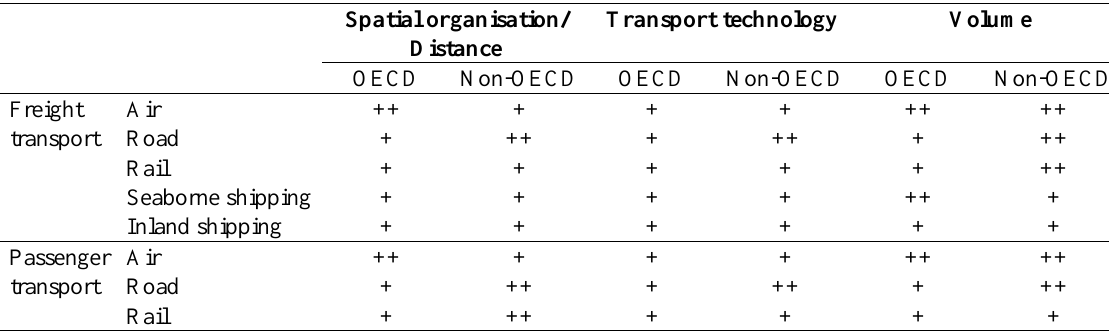
Table 1. Scenario 1: